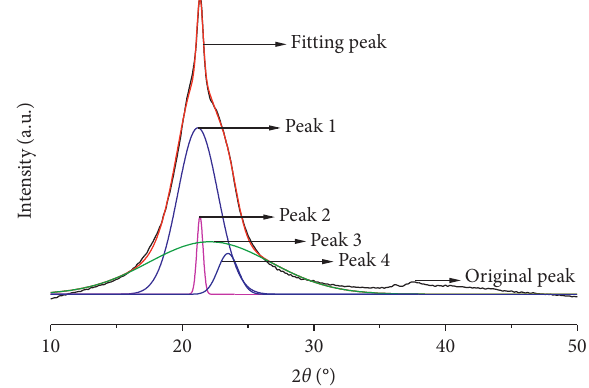
Figure 5: XRD fitting diagram of pure PA fiber.